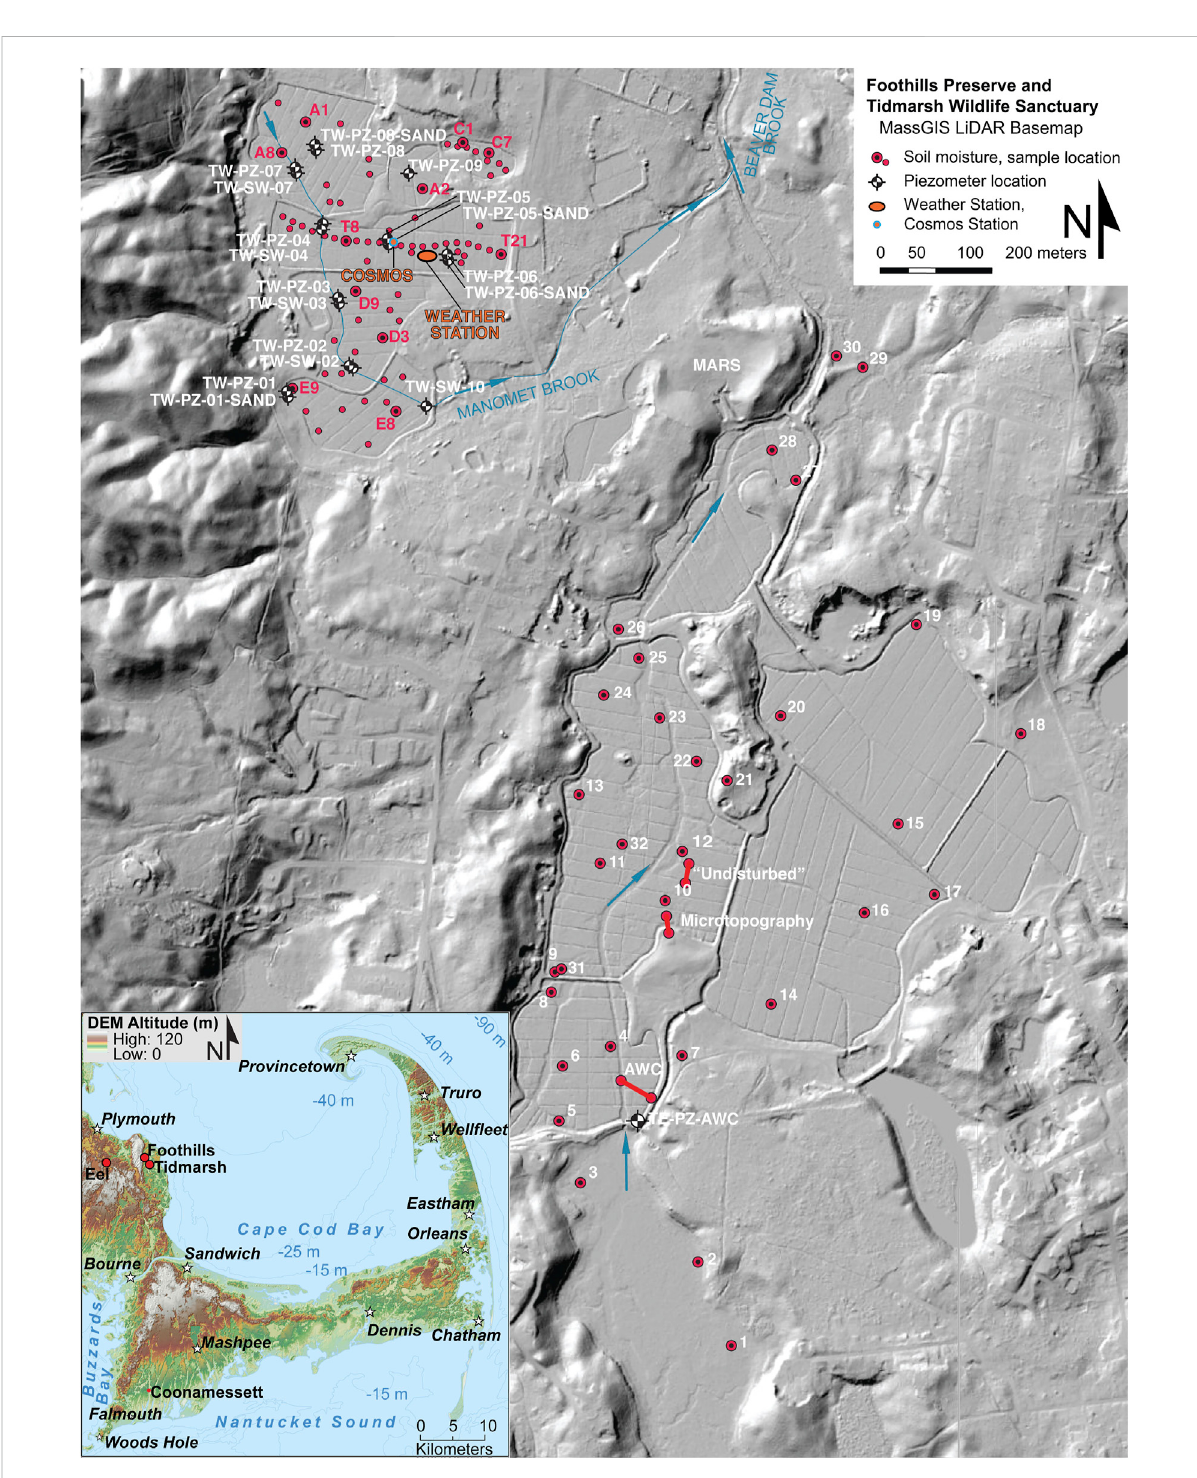
FIGURE 1 Shaded relief LiDAR terrain DEM showing the locations of samples, monitoring, and piezometers at Foothills Preserve (Town of Plymouth) and Tidmarsh Wildlife Sanctuary (Mass Audubon) on a shaded relief LiDAR (available at https://docs.digital.mass.gov/dataset/massgis-data-lidar-terrain- data). Stream fl ow direction arrows. (inset) Location of the two focus cranberry farms/restoration sites: Foothills Preserve and Tidmarsh on a digital elevation model (DEM) from MassGIS (Bureau of Geographic Information) Data: LiDAR Terrain Data Mapped by the Massachusetts Geological Survey (https://mgs.geo.umass.edu), Stephen B. Mabee, personal communication